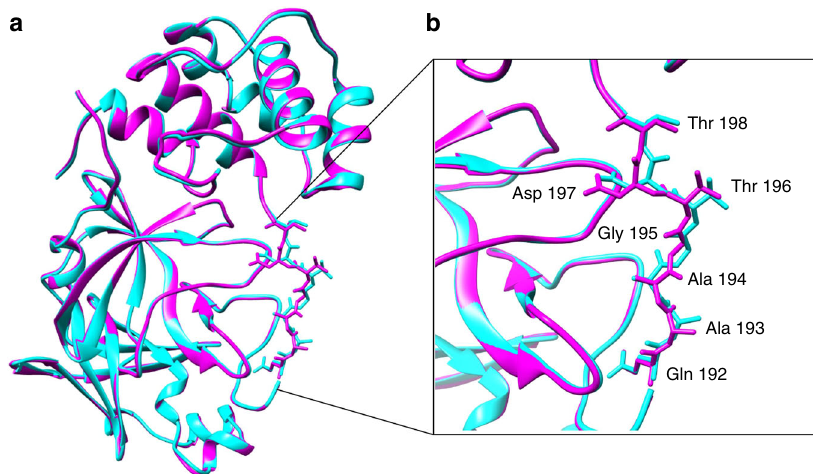
Fig. 3 Comparison of room-temperature and low-temperature structures. a A superposition of our room temperature ligand-free structure of 3CL M pro (magenta) with the ligand-free structure of 3CL M pro (PDB ID 6Y2E) obtained at 100 K (cyan). b Residues 192 – 198 in the P5 binding pocket differ in conformation between the room temperature and 100 K structures.